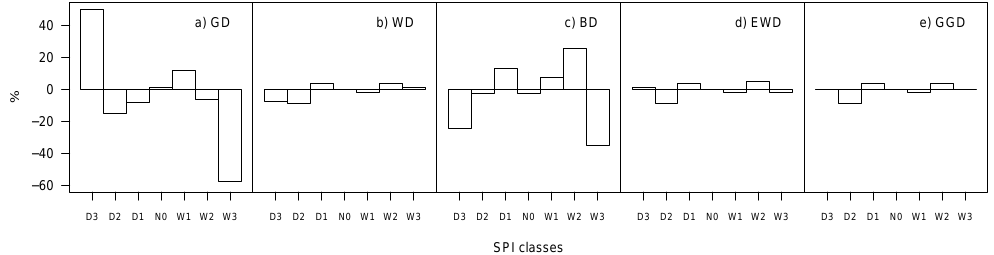
Fig. 3. SPI time series for England and Wales precipitation. SPI transformation is calculated with (a) GD and (b) WD. Wet (dry) SPI extremes are highlighted in blue (red).